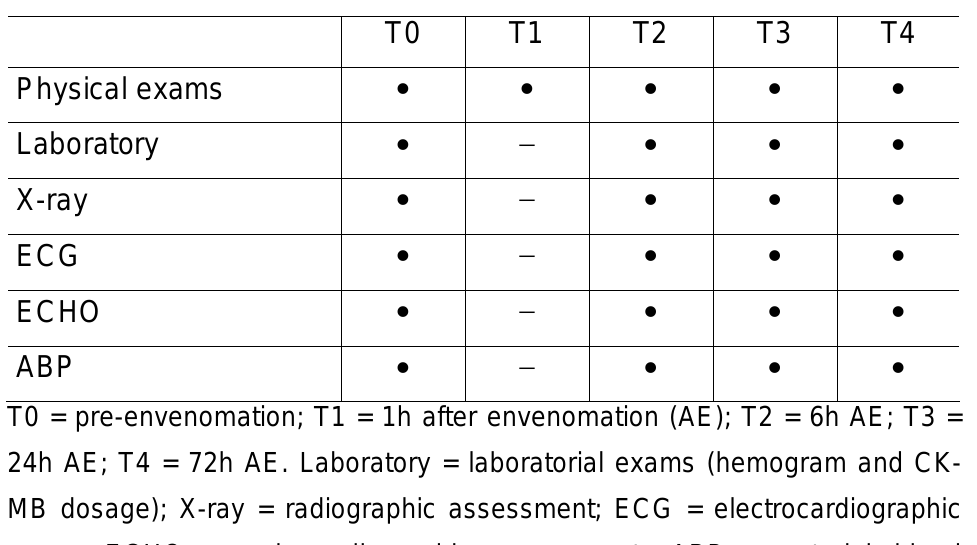
Table 1: Analyses according to the envenomation time. Botucatu, São Paulo, Brazil, 2003.